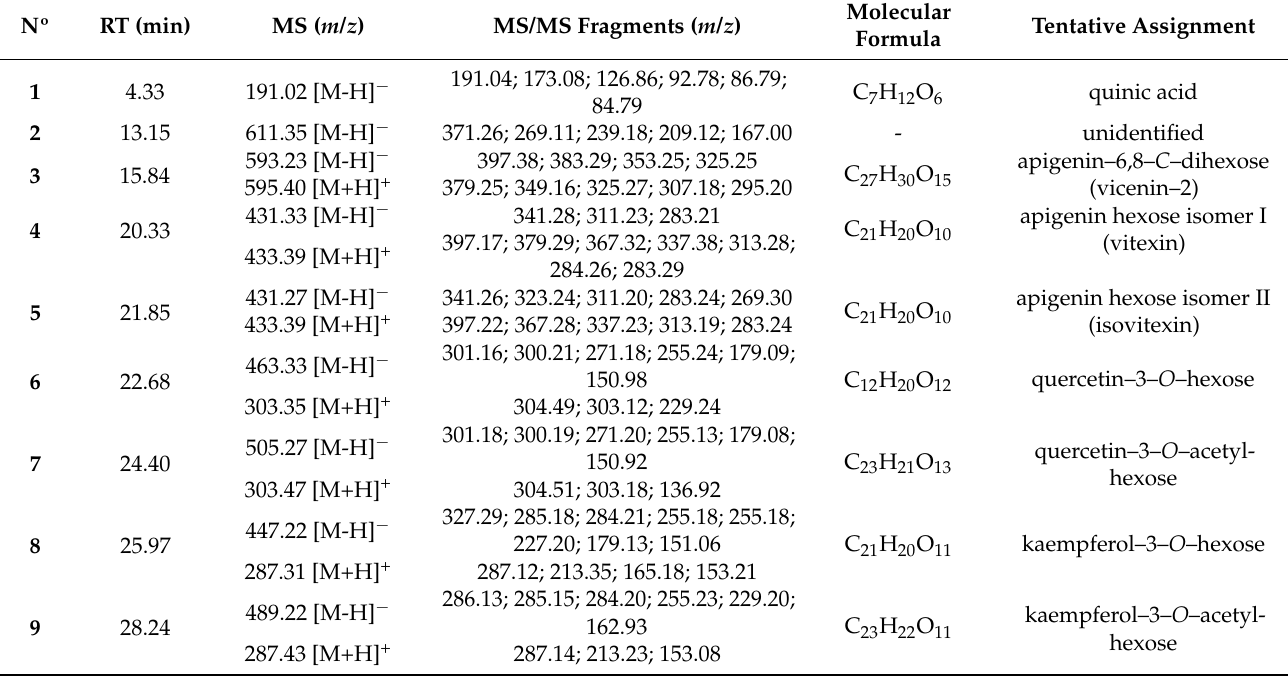
Table 4. HPLC-ESI-QTRAP-MS/MS data of the compounds identified in M. oleifera hydroethanolic leaf extract (MOL-Flav) in the first harvest of the mineral cultivation condition